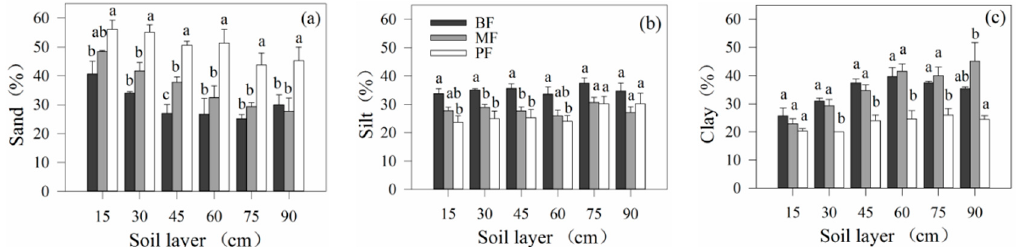
Figure 3. Soil mechanical composition including sand ( a ), silt ( b ), and clay ( c ) contents of the 0–90 cm soil layer of the different forests. Values are the means ± SE. Lowercase letters above the columns represent statistically significant differences among stand types for the same soil layer (Duncan’s test, p < 0.05). Abbreviations: PF, Pinus massoniana forest; MF, mixed Pinus massoniana /broad-leaved forest; BF, monsoon evergreen broad-leaved forest.